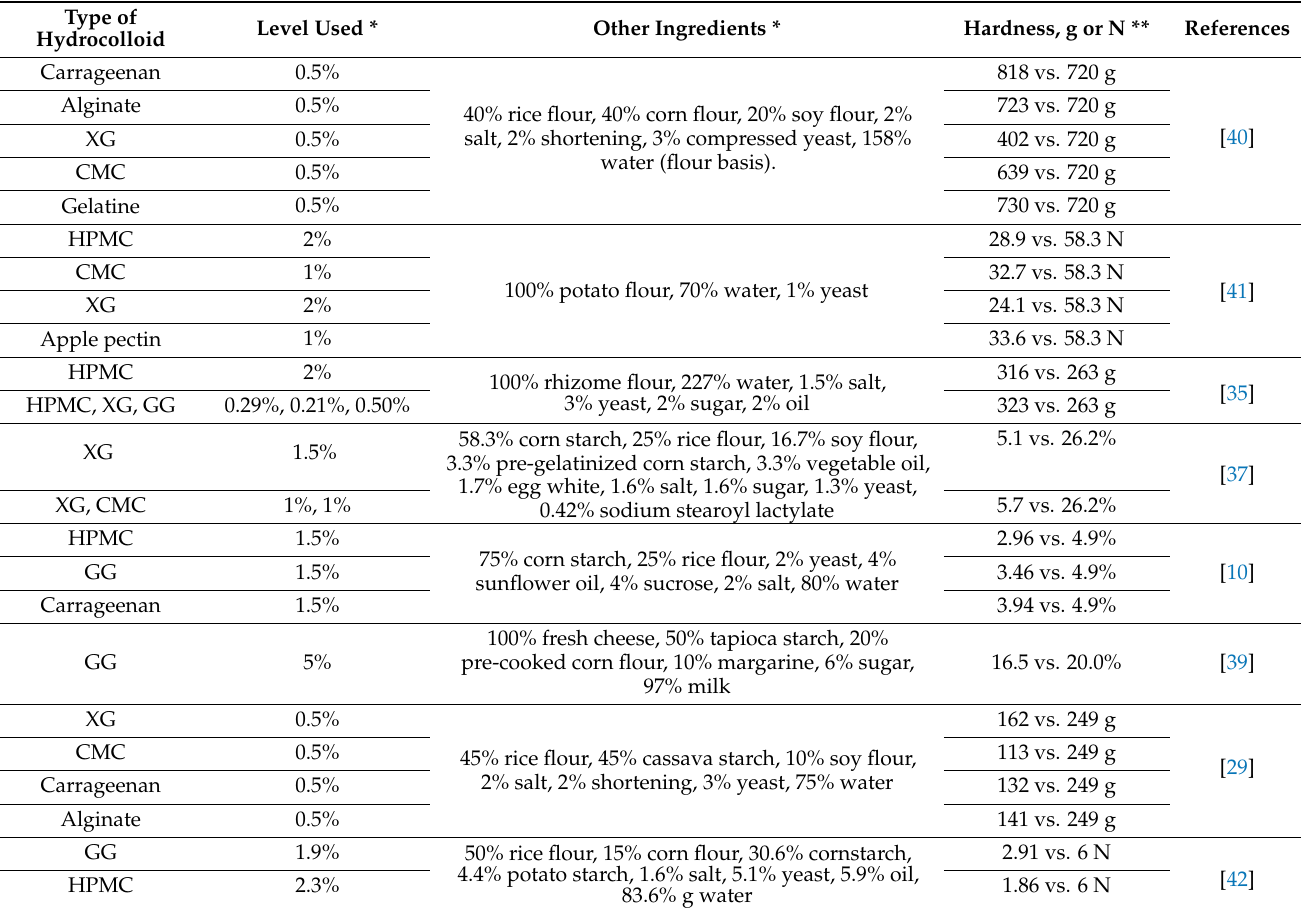
Table 2. Effect of hydrocolloids on bread hardness compared to